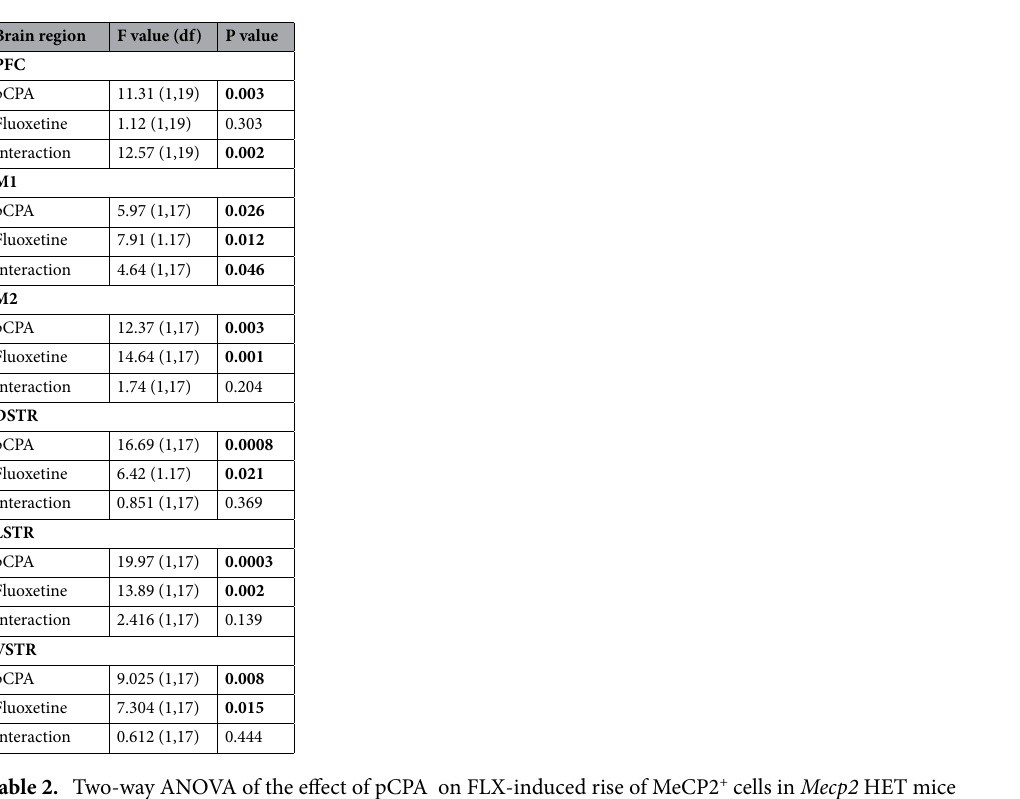
Table 2. Two-way ANOVA of the effect of pCPA on FLX-induced rise of MeCP2 + cells in Mecp2 HET mice shown in Figs. 4 and 5. Significant effects are highlighted in bold